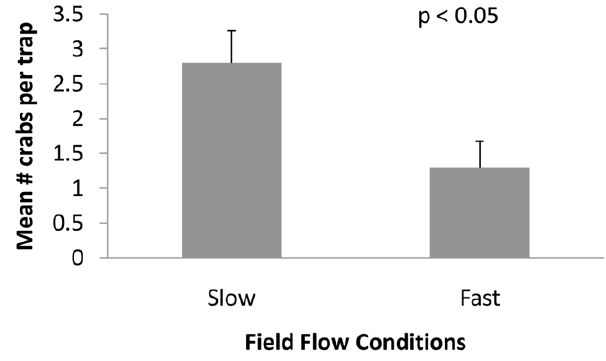
Figure 2. Mean number ( ± SE) of C.maenas caught per trap in field locations with low and high flow velocities. Means were compared using a t-test and were significantly different (p , 0.05, n=19).